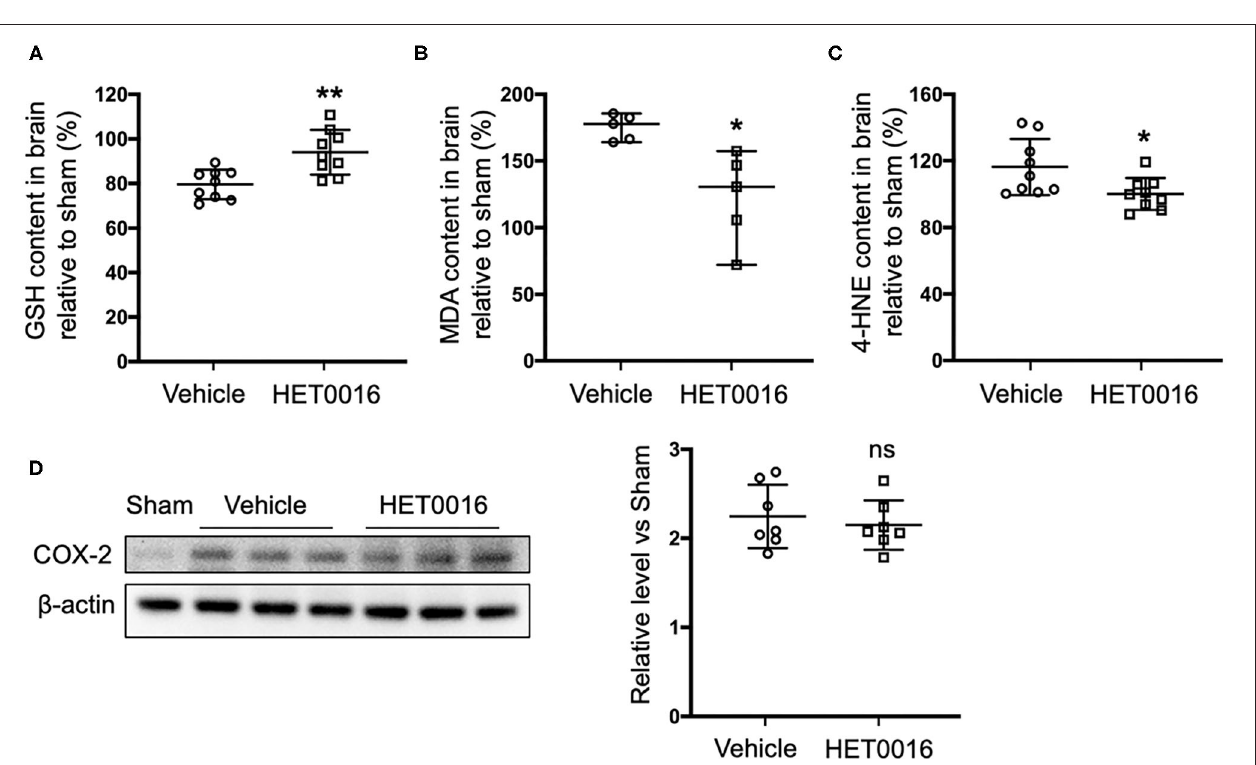
FIGURE 4 | n = 8–10/group. (C) Examples of cresyl violet (CV)/luxol fast blue–stained serial brain sections from vehicle- and HET0016-treated mice 3 days after ICH. Lesion volume was similar on day 1 but significantly less on days 3 and 7 in the HET0016-treated group. n = 8–10/group. (D) Representative images of 3,3 ′ -diaminobenzidine (DAB)-enhanced Perls’ staining shows iron deposition at 3 and 7 days after ICH. Scale bar is 200 µ m. The number of iron-positive cells was lower in the HET0016-treated group than in the vehicle-treated group. n = 6–9/group. * P < 0.05, ** P < 0.01. Mann–Whitney U -test (A,B) or unpaired t -test (C,D) was applied between vehicle and HET0016 groups at each time point. Data are expressed as median with confidence interval (A,B) or mean ± SD (C,D) .